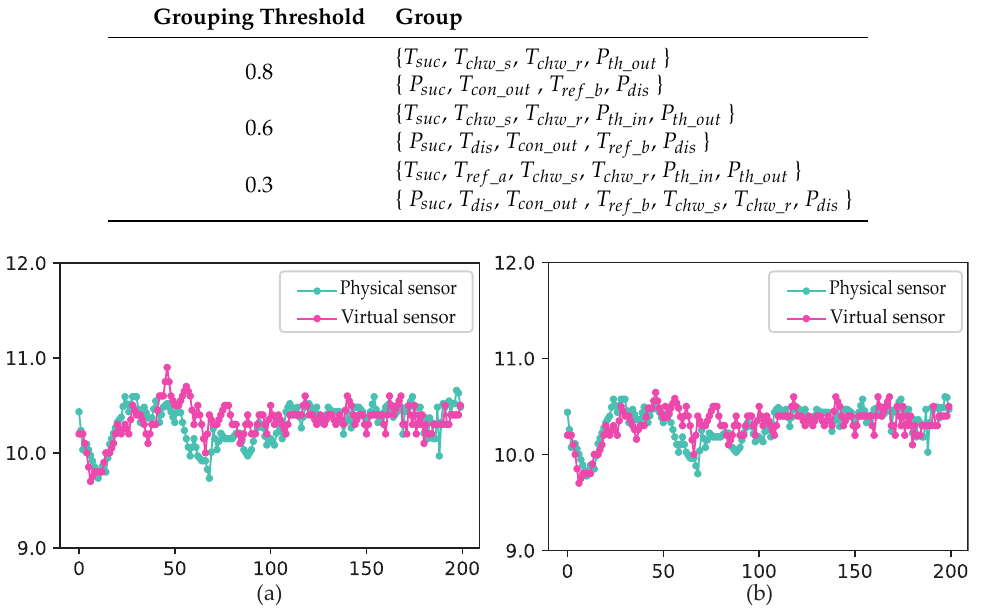
Figure 4. ( a ) Predictive result of virtual sensor V 1